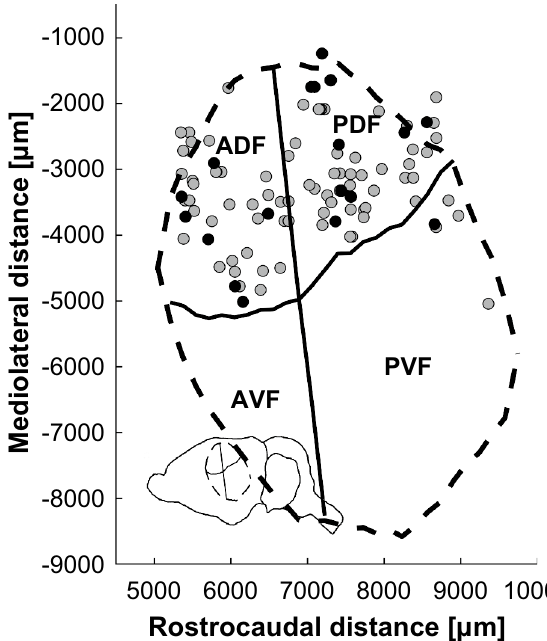
Figure 5. Recording sites and subfields in the auditory cortex (AC) of P. discolour . Projections of recording sites (gray & black circles) on an unrolled and flattened cortical surface with schematic AC subfields: anterior dorsal field (ADF), posterior dorsal field (PDF), anterior ventral field (AVF) and posterior ventral field (PVF). Units that showed a significant response rate decrease are marked by black circles. Inlay shows overall position of the AC in the brain of P. discolor